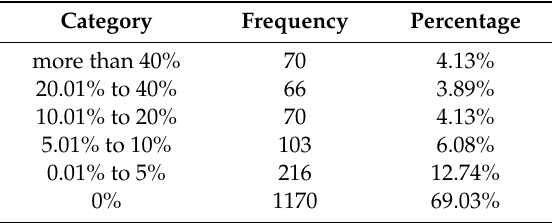
Table 1. Percentage of dreams that include dogs ( n = 1695).